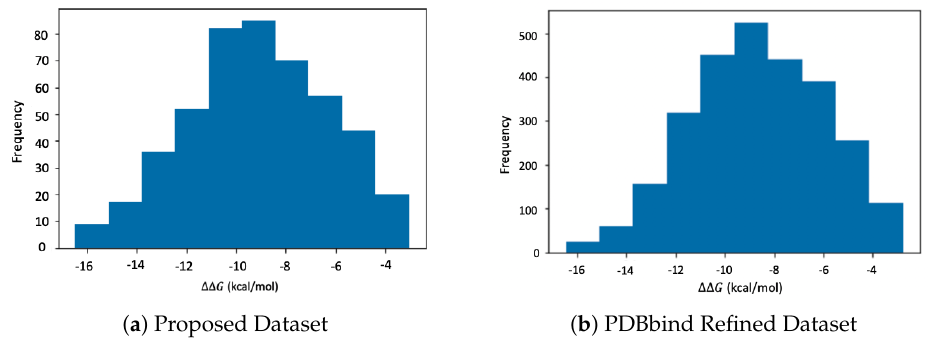
Figure 2. Distribution of ∆∆ G values of PDBbind refined set vs. our sample